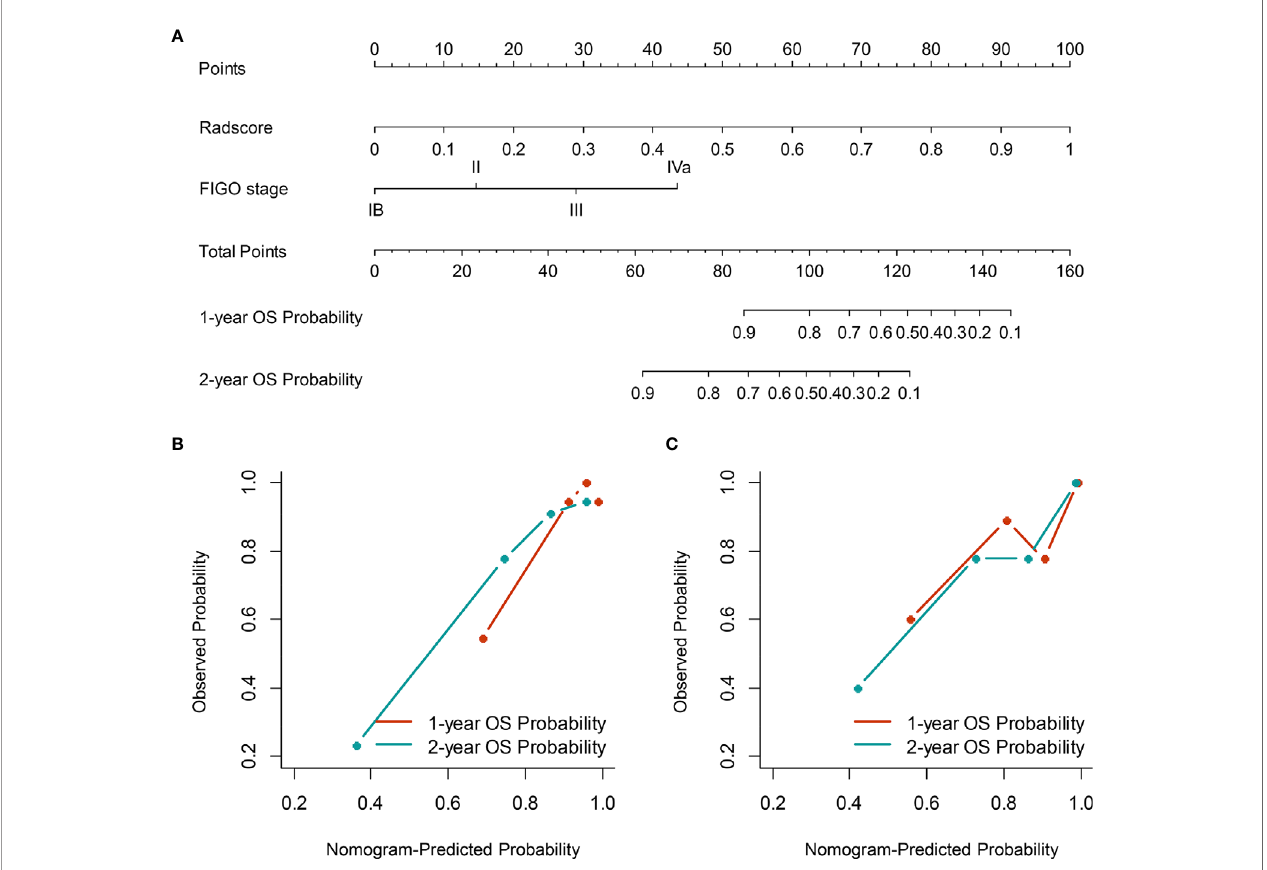
FIGURE 3 | The nomogram (A) based on the FIGO stage and Radscore was used to estimate OS individually, along with the assessment of the model calibration. Calibration curves for the nomogram to the 1-year and 2-year OS rate in the training (B) and validation cohorts (C) . FIGO, International Federation of Gynecology and Obstetrics; OS, overall survival. signi fi cantly improve the performance of the FIGO stage for OS evaluation. The combined model yielded the optimal